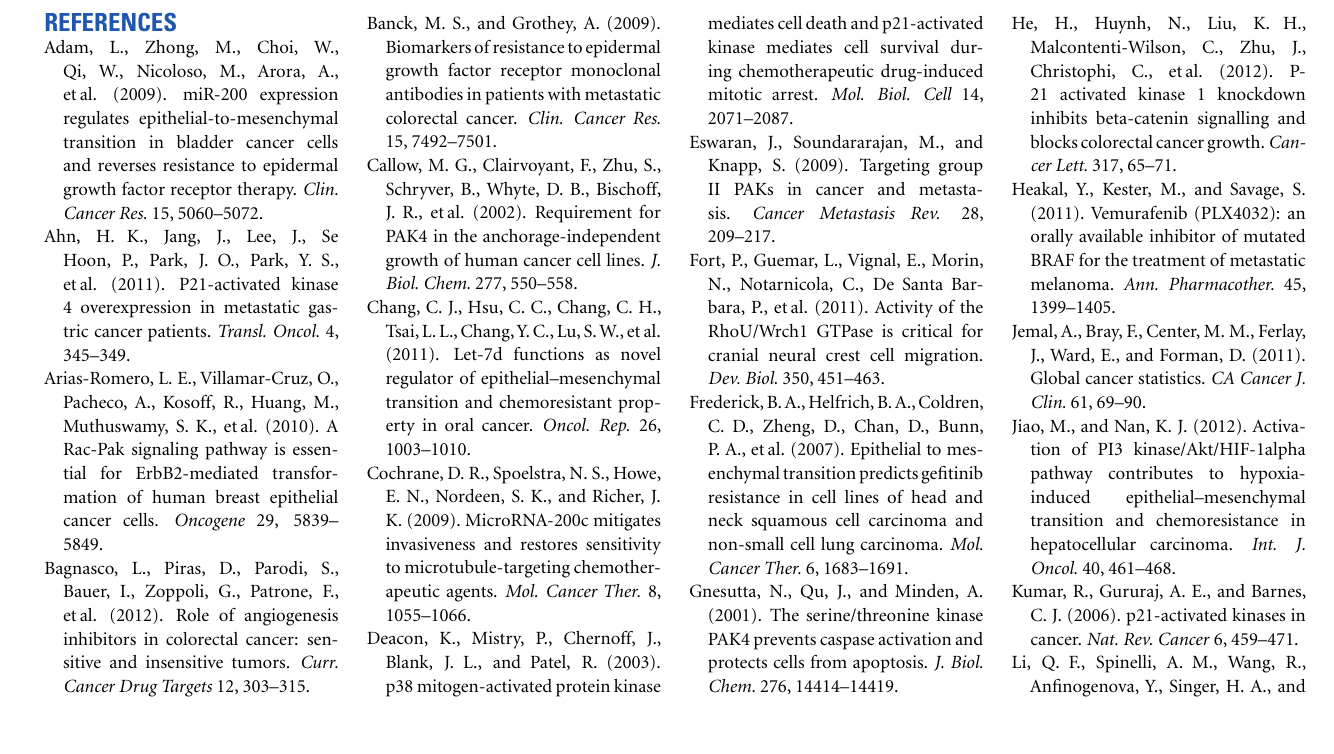
To explore the functional relationship between EMT mark- ers and responsiveness to PF-3758309, we carried out several experiments targeting known genes and transcriptional regula- torsof EMT.Wedemonstratedthatwhenmesenchymal-associated genes were suppressed in CRC cell lines exposed to PF-3758309, a shift to a more resistant phenotype was observed in vitro pro- liferation assays. This is in direct contrast to non-small cell lung cancer (NSCLC) cells, where the knock down of Zeb-1 results